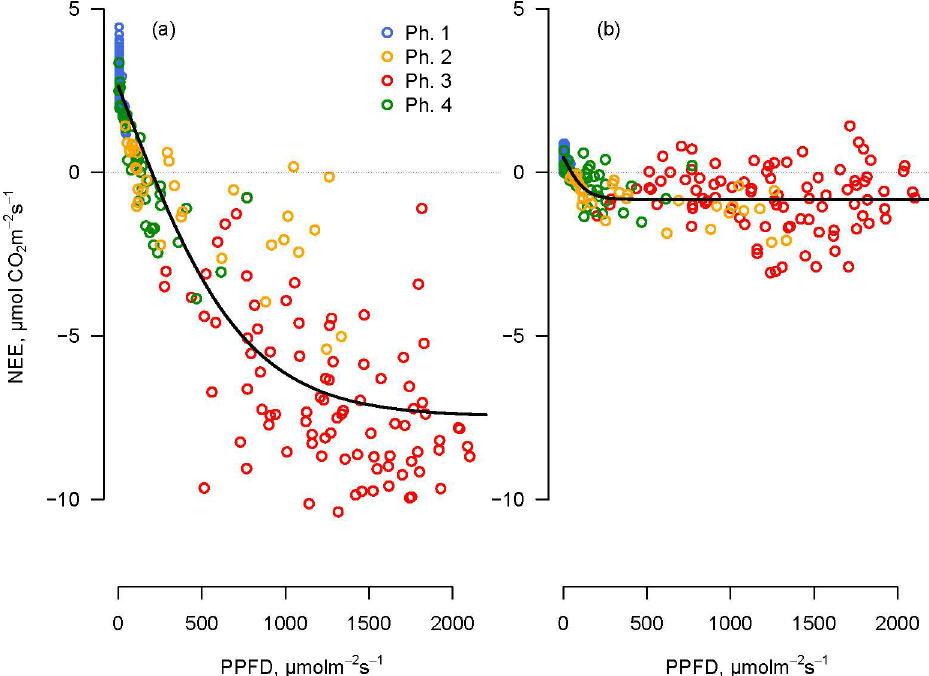
Fig 3. NEE of (a) Festuca and (b) Sempervivum measuredwith clear chambersas a function of photosynthetic active photon flux density (PPFD). Data reportedcorrespondto a week of measurements in 2012 (7 August 2012–14August 2012). The solid line indicatesthe apparentresponseto light obtained using Eq (1). Each color of the dots indicatesone of the four “Osmond phases” in which the flux was measured, accordingto Fig 2 the four phases are presented for Festuca plots only with the purposeof simplifyingthe comparisonbetweenthe two vegetationcommunities in the same time